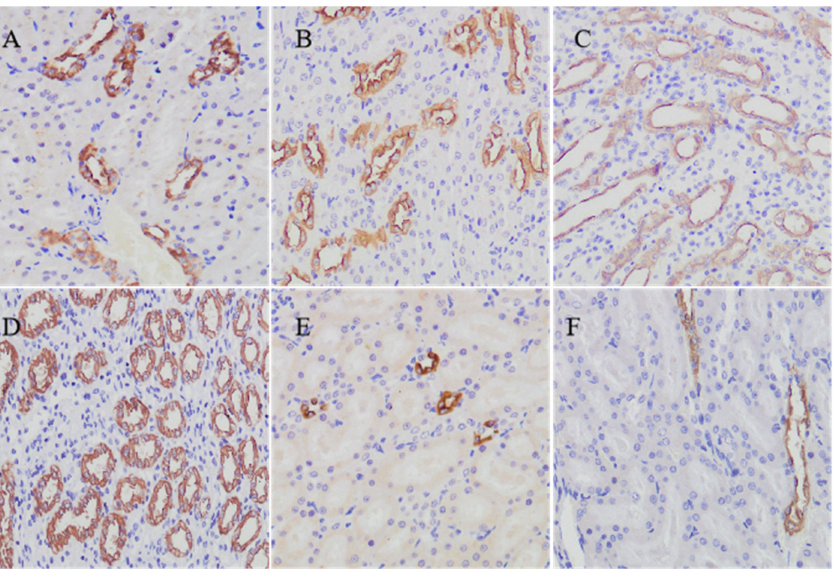
Figure 6. IHC analysis of Aqp2 on the kidneys collected at day six from ( A ) the normal control rats. Diarrhea-rats induced by ( B ) low dose of senna anthraquinones. ( C ) high dose of senna anthraquinones. ( D ) low dose of rhubarb anthraquinones. ( E ) high dose of rhubarb anthraquinones. ( F ) sennoside A (SA). Magnification: 200 ×